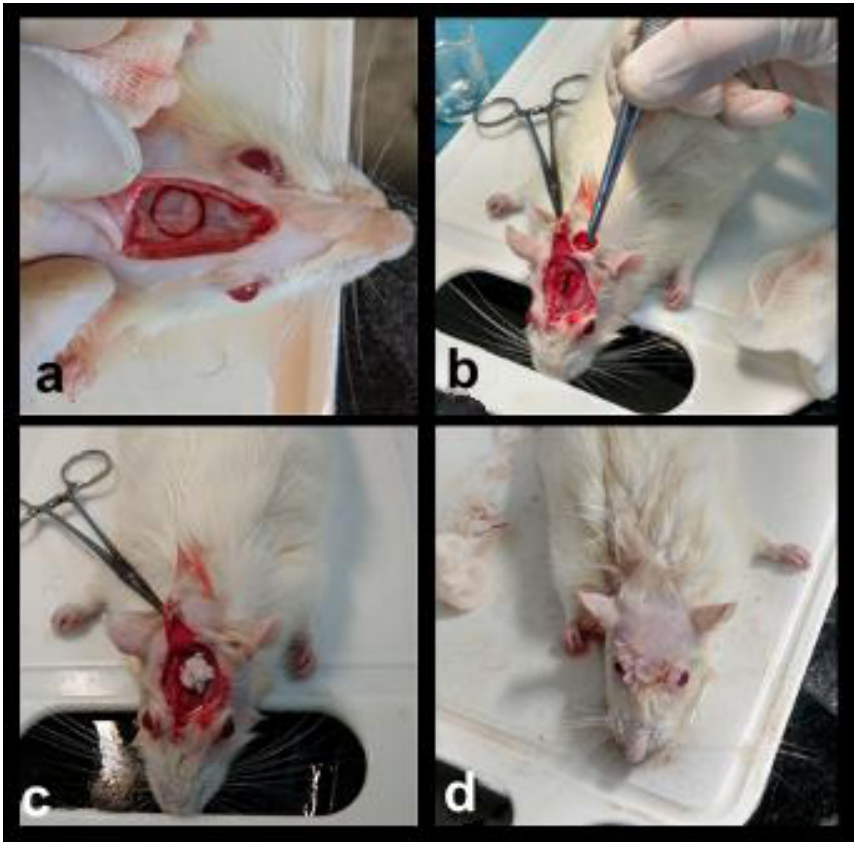
Figure 2. Surgical sequence ( a ) demarcation of the bone defect with 8 mm trephine ( b ) removal of the bone defect with exposure of the dura, ( c ) filling of the bone defect with biomaterial, ( d ) final suture.